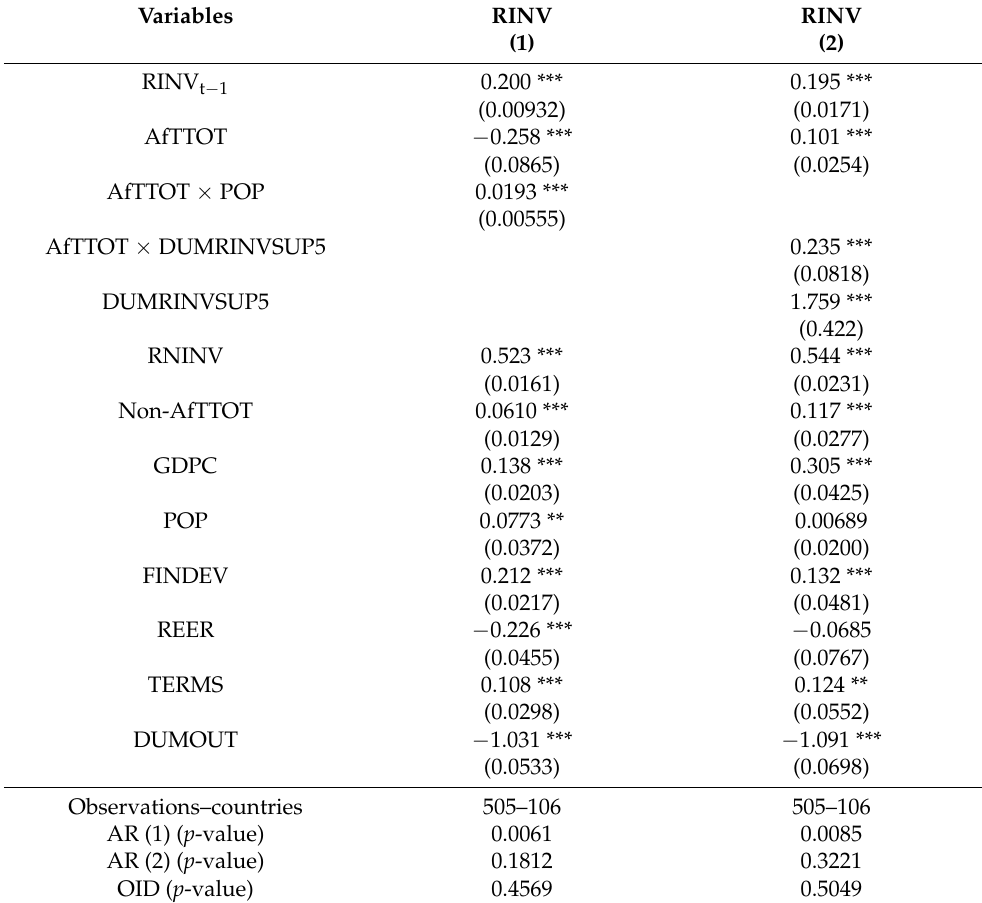
Table 4. Effect of AfT flows on investment-oriented remittance flows. Estimator: Two-step sys- tem